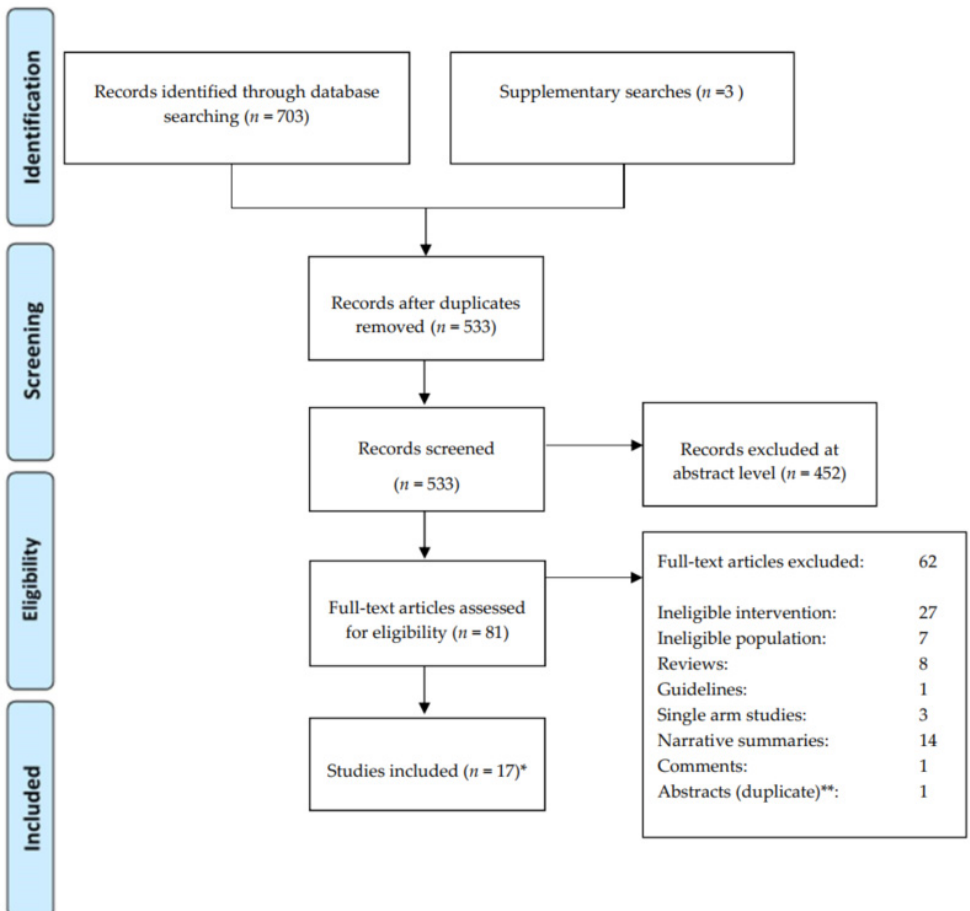
Figure 1. Results of bibliographic literature search and study selection (PRISMA 2009 flow diagram). * 18 studies included, corresponding to 19 published reports. No publication of the ESOSTRATE (Comparison of Systematic Surgery Versus Surveillance and Rescue Surgery in Operable Oesophageal Cancer With a Complete Clinical Response to Radiochemotherapy) protocol could be identified. ** This abstract refers to results reported in the included ESOPRESSO trial (A Randomized Phase III Trial on the Role of Esophagectomy in Complete Responders to Preoperative Chemoradiotherapy for Esophageal Squamous Cell Carcinoma), no additional results are